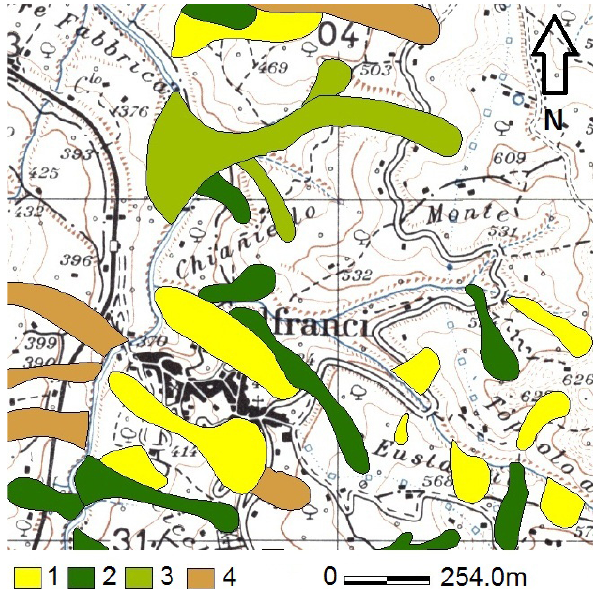
Fig. 1b. IFFI landslide map at Castelfranci. Legend: (1) transla- tive/rotational sliding mechanism; (2) earthflow; (3) mud flow; (4) complex landslide mechanism.